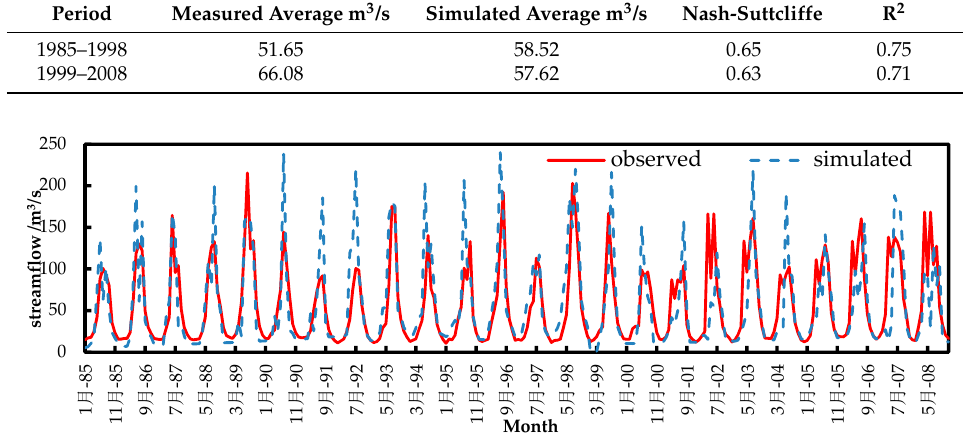
Figure 3. Calibration and validation results of SWAT model for monthly streamflow.